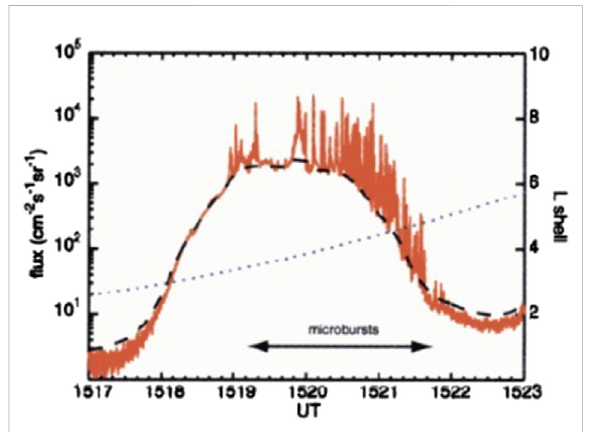
FIGURE 1 ElectronmicroburstobservationsfromLorentzenetal.,2001. Electrons > 1 MeV microbursts observed on 19 October 1998 (red). Estimate of the locally trapped population (black dashed line). L-shell position of satellite (blue dotted